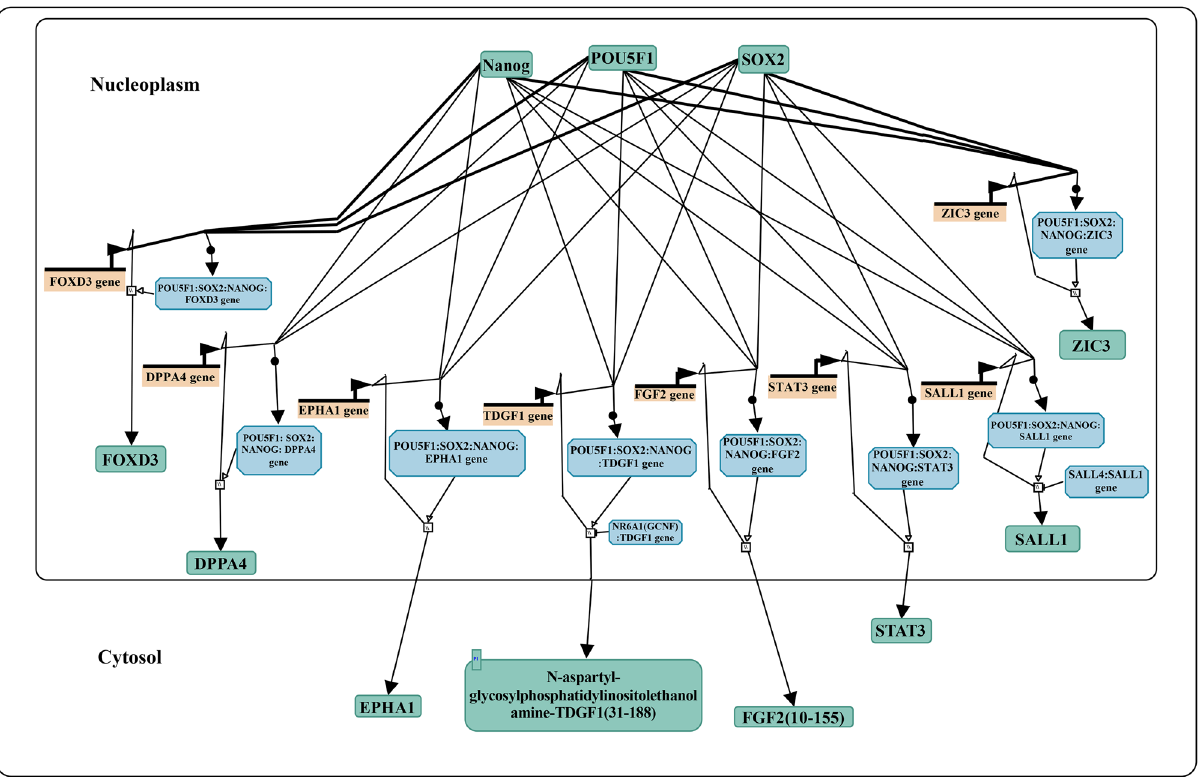
Figure 8. Both FOXD3 and ZIC3 are involved in pluripotency regulation pathway. The figure has been obtained and modified under CC-BY 4.0 international license from Reactome. An interactive version with links to detailed pathway representation is accessible https ://react ome.org/conte nt/detai l/R-HSA-28922 47. It shows that NANOG, POU5F1 (OCT4) and SOX2 bind to the promoters of different target genes which further activates or suppresses the expression of those target genes 43–46 . The mentioned genes in this figure have been described to be involved in the core transcriptional network of pluripotent stem cells 47–49